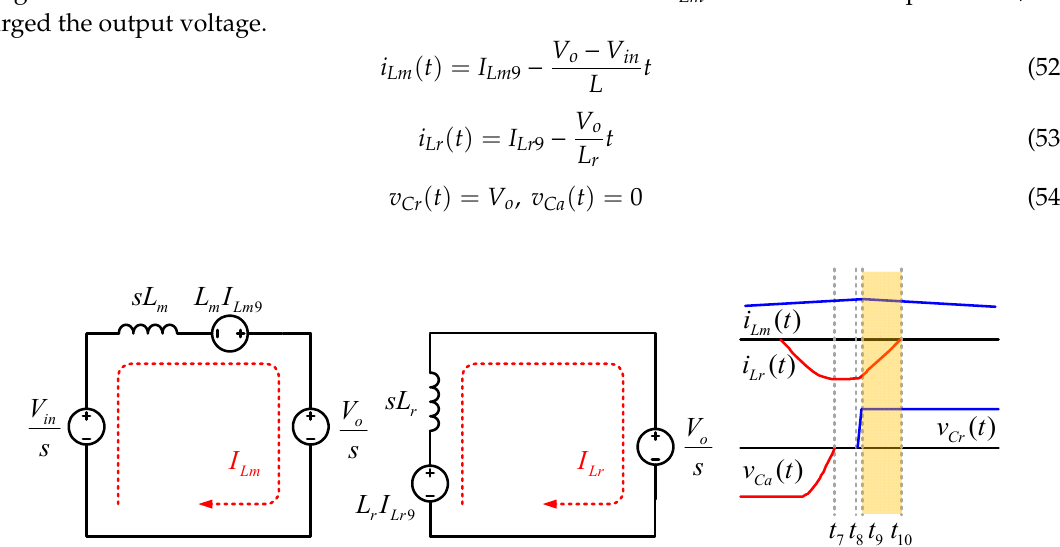
Figure 13. The equivalent circuit of Mode 10 and key waveform.